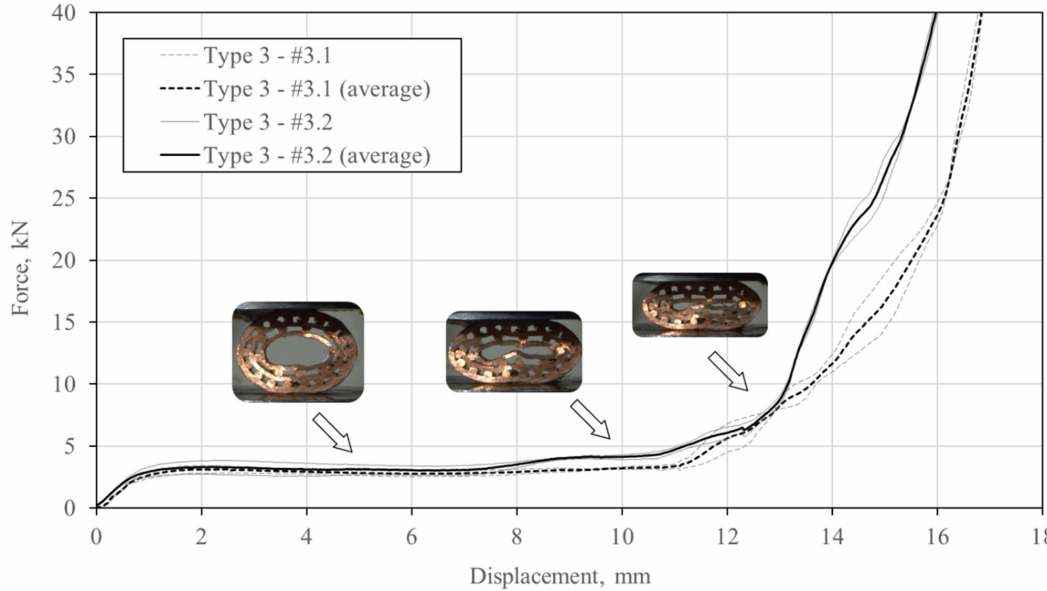
Figure 13. Compressive force–displacement relationship of the type 3